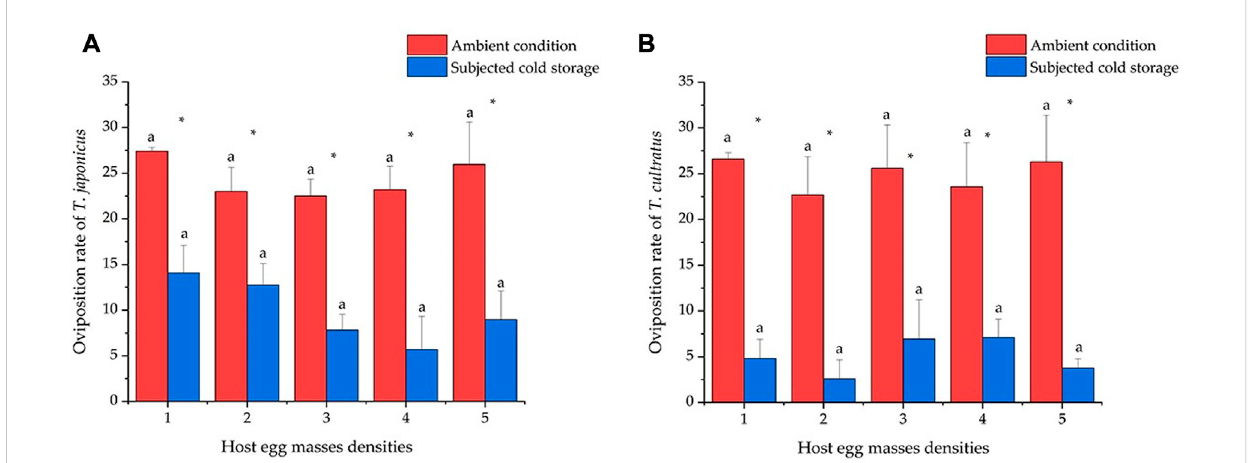
FIGURE 6 Daily per female oviposition rate of T. japonicus (6A) and T. cultratus (6B) when individual females were offered one to fi ve host egg masses. Values are means ± SE. Asterisks represent statistically signi fi cant differences between wasps placed in ambient conditions (25 ° C) and wasps subjected to 19 weeks of cold storage (11 ° C) at the same host density level. Lowercase letters represent no signi fi cant difference between different host densities by each parasitoid species ( p >